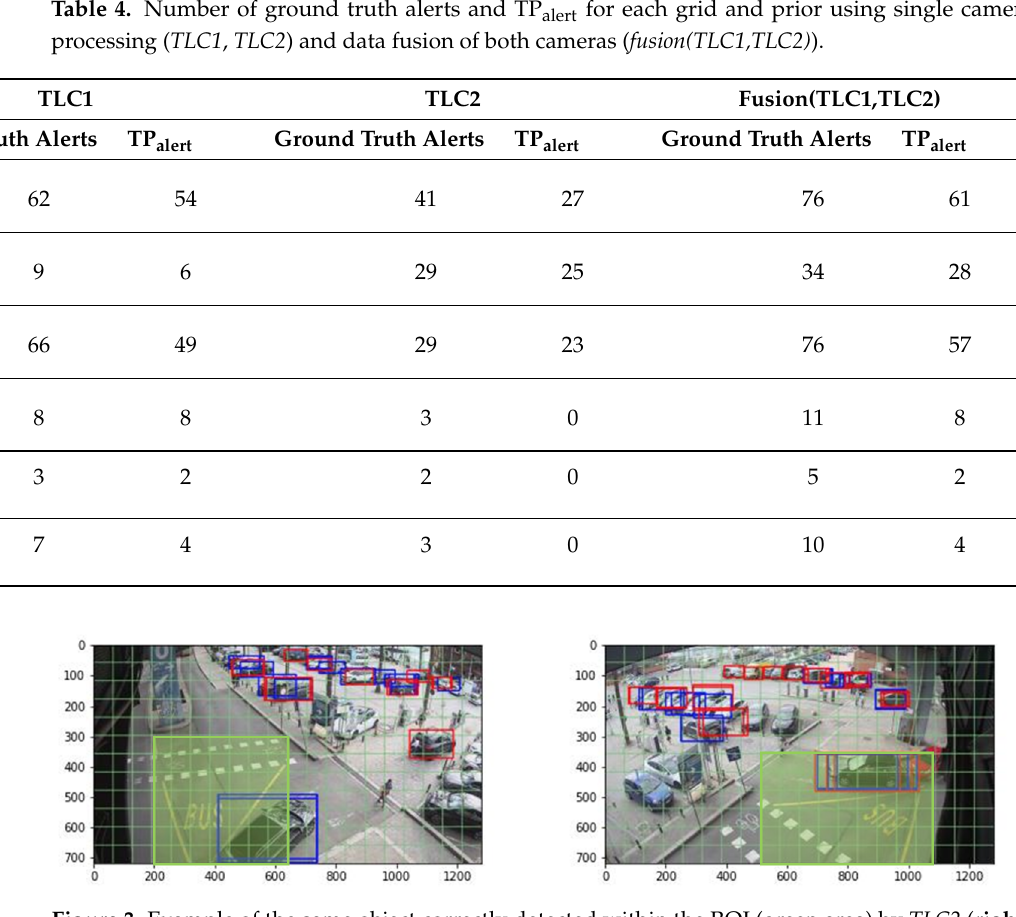
Figure 3. Example of the same object correctly detected within the ROI (green area) by TLC2 ( right ), but missed by TLC1 ( left ). Ground truth boxes are shown in blue, while predicted boxes are shown in